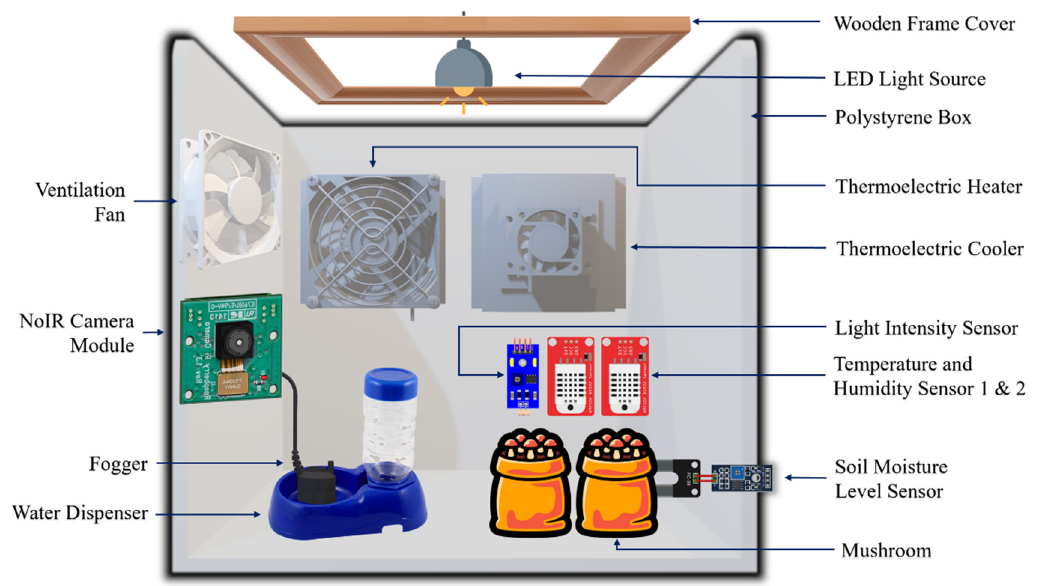
Figure 1. The design of the home-based mushroom cultivation chamber.